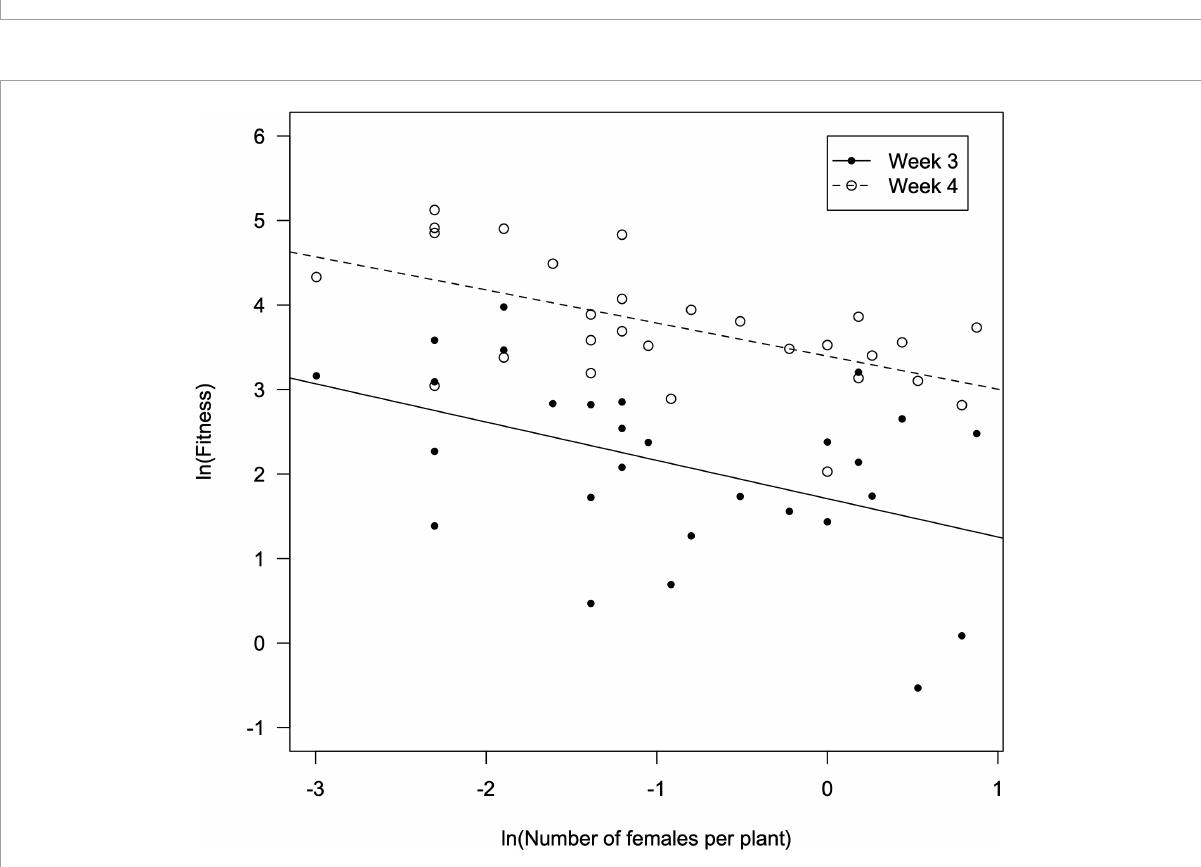
FIGURE3 Average of D. hesperus nymphs per tomato plant with standard errors (21 and 28 days after the introduction of tomato plants with prey in the glasshouses) in three habitats (MC, WC, and WMC) composed by patches with different food resources (No prey- C-, mites- M-, whiteflies-W-).